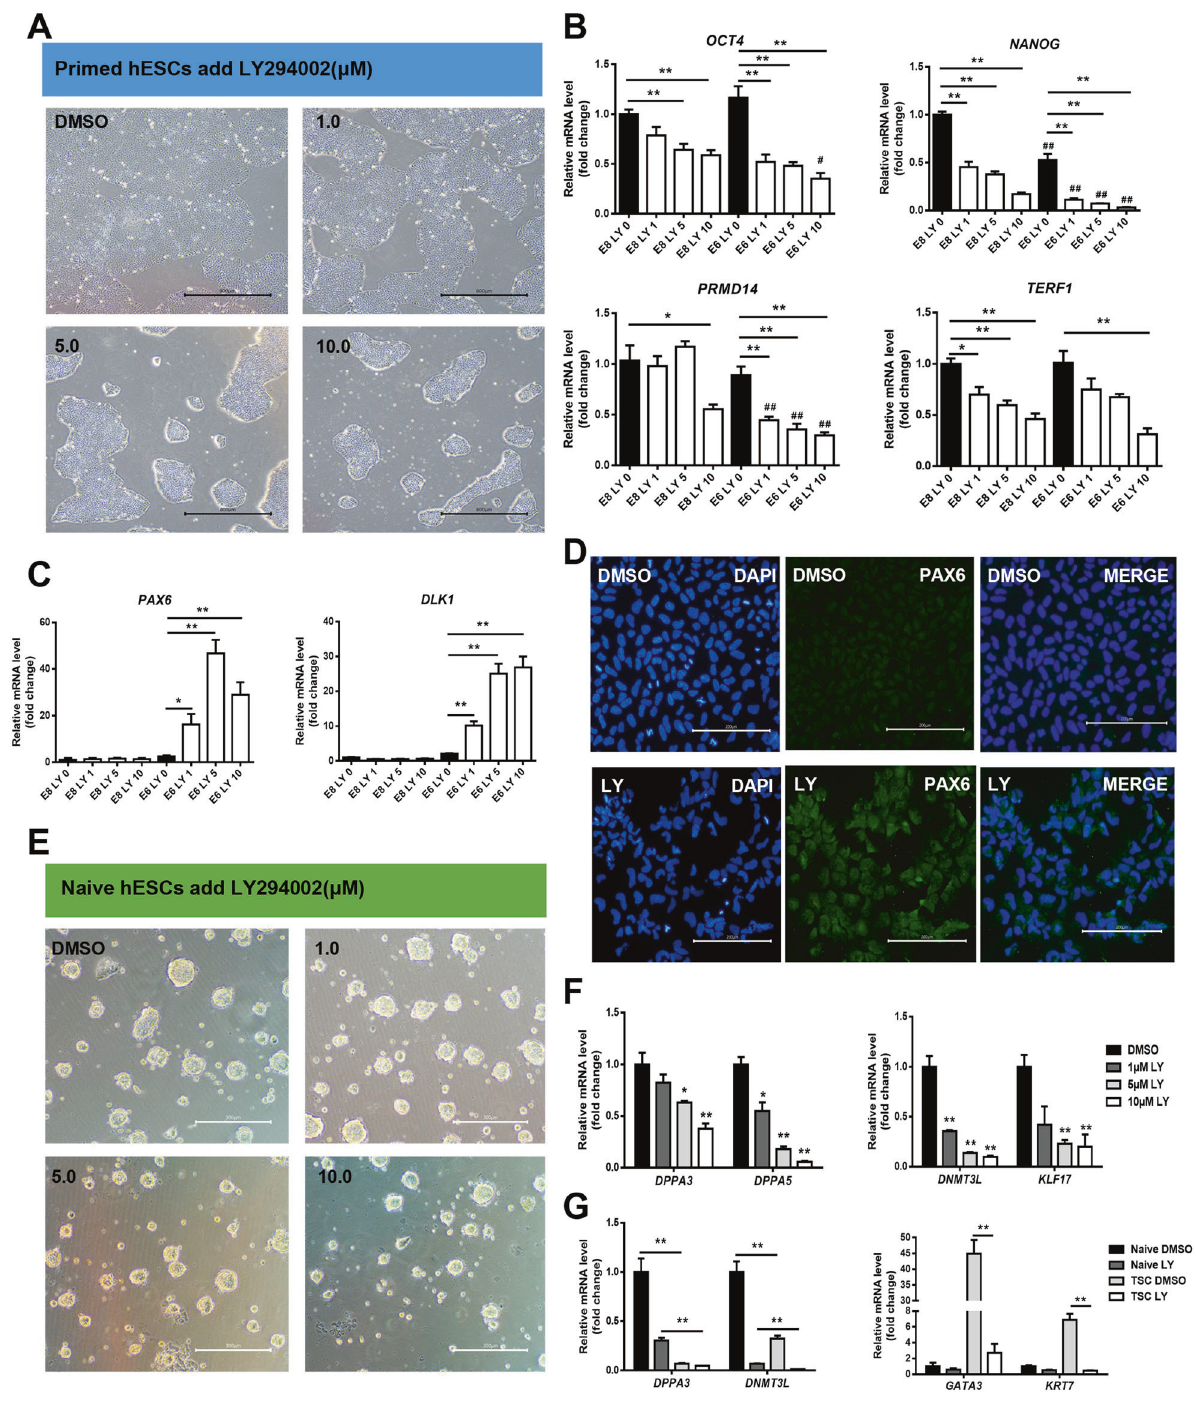
Fig. 5 Inhibition of AKT phosphorylation promotes pluripotent dissolution and impedes the primed-to-naive transition. A Morphology of primed hESCs after stimulation for 48 h with the PI3K/AKT inhibitor LY294002, at different concentrations bar = 300 μ m. B , C Quantitative gene expression analysis for pluripotent marker genes OCT4 , NANOG , PRMD14 , and TERF1 ( B ) and the neuroectoderm marker genes PAX6 and DLK1 ( C ) in the primed hESCs after culture for 72 h in E8 and E6 medium with different concentrations of LY294002 separately ( n = 3), data are presented as means ± SEM, compared to E8 LY 0 and E6 LY 0, * p < 0.05; ** p < 0.01, one-way ANOVA followed by t -test. D Immuno fl uorescence analysis of PAX6 expression level in primed hESC after cultured 72 h in E6 medium supplemented with 5 μ M LY294002, bar = 300 μ m. E Morphology of naive-like hESCs after stimulation for 48 h with the PI3K/AKT inhibitor LY294002 at different concentrations, bar = 300 μ m. F qPCR detection of the naive marker genes mRNA levels in naive-like hESCs after treated with different concentration of LY294002 ( n = 3), data are presented as means ± SEM, compared to DMSO, * p < 0.05; ** p < 0.01, one-way ANOVA followed by t -test. G Naive marker gene and TSC gene expression levels in naive like cells and TSC that treated with LY294002 at different concentration ( n = 3), data are presented as means ± SEM, compared to DMSO, * p < 0.05; ** p < 0.01, one-way ANOVA followed by t